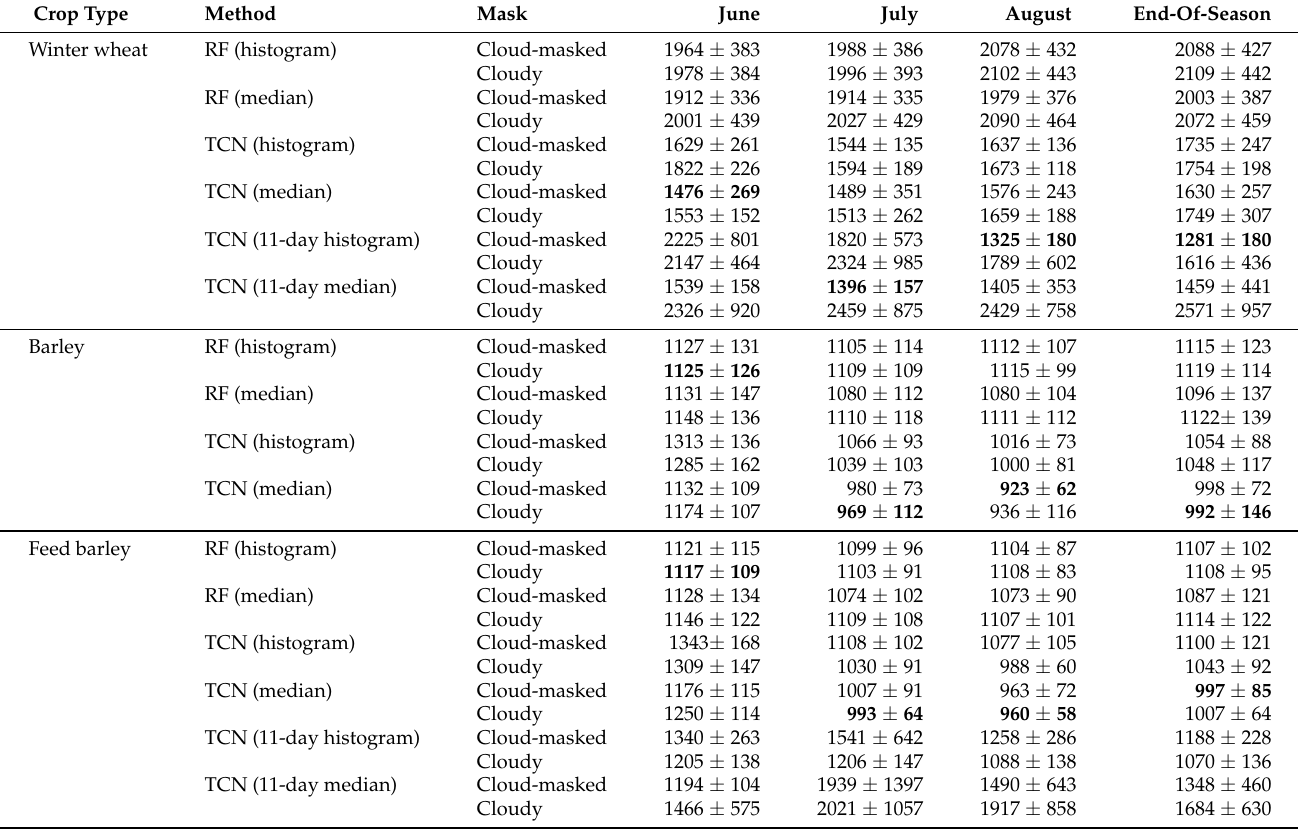
Table A1. The farm-level mean and standard deviations of root mean square errors (kg/ha) on test set validation with 10 training iterations of Temporal Convolutional Network (TCN) and random forests (RF) models when using crop type-wise subsets and median or histogram based features. The lowest mean error (crop-wise) at forecast time is printed in